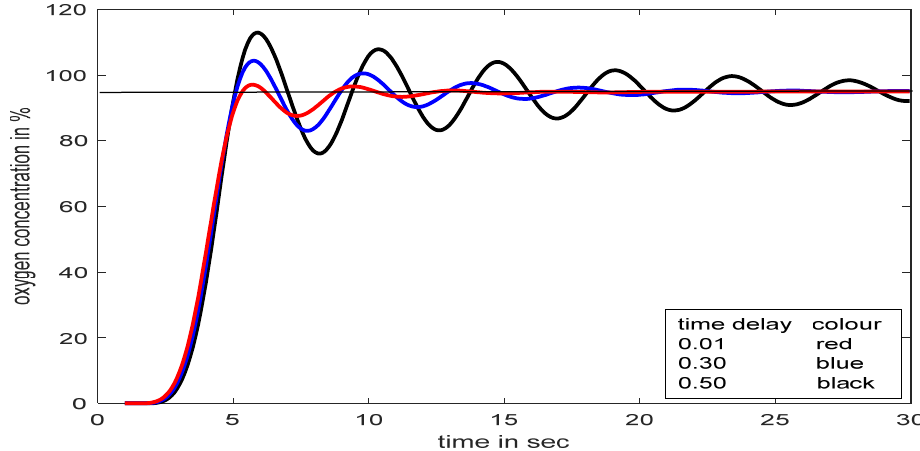
Figure 19. Process responses with SFPIMRAC with different time delay.